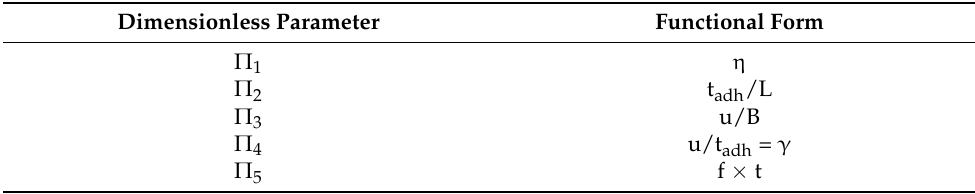
Table 4. Defined dimensionless parameters Π 1 to Π 5 based on